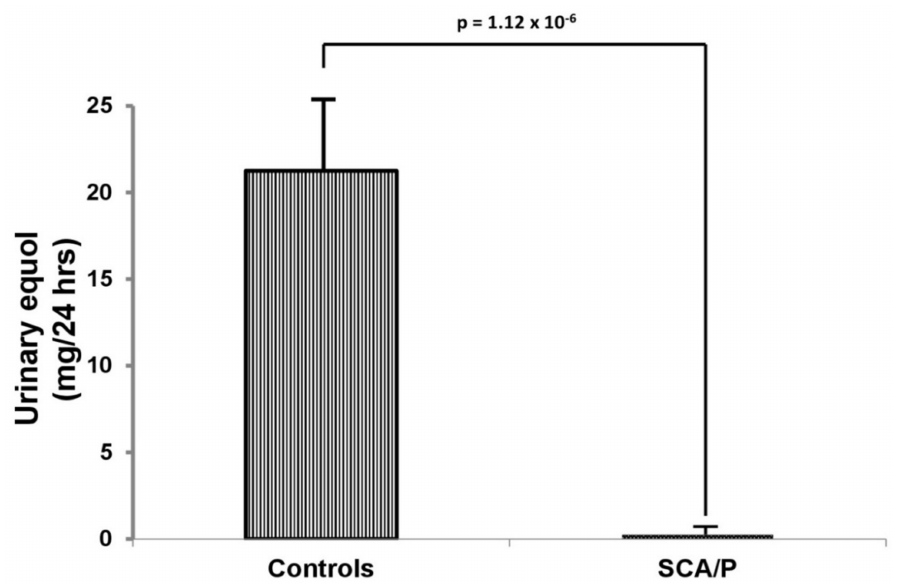
Figure 4. Urinary concentrations of equol in control and SCA / P subjects.